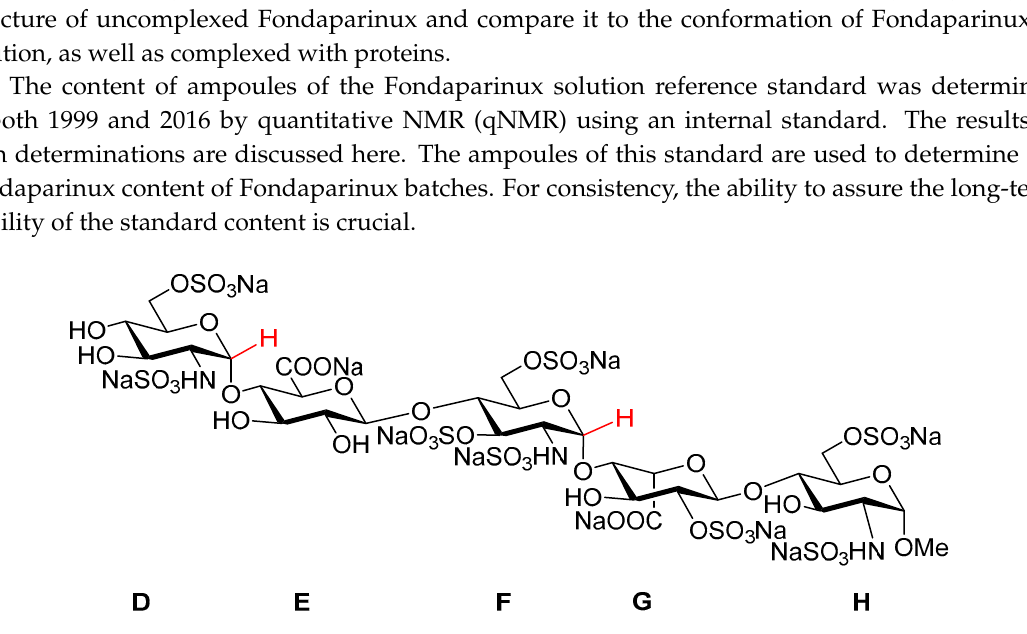
Figure 1. Structural formula of the synthetic anticoagulant pentasaccharide Fondaparinux sodium. The anomeric D1 and F1 protons used for qNMR integration have been indicated in red.